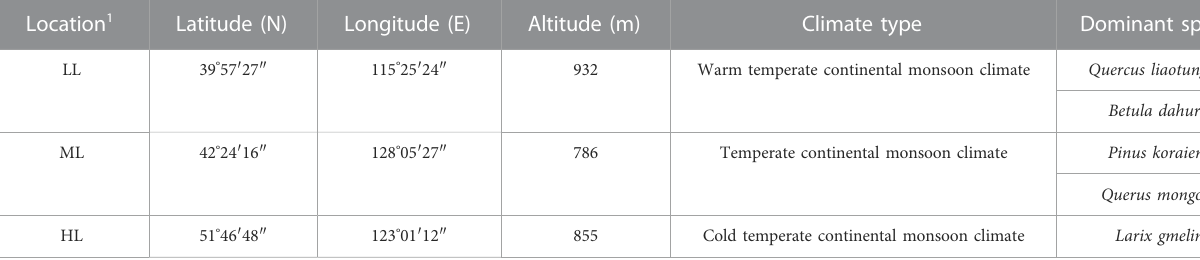
TABLE 1 Basic information of the selected forests in China temperate zones. Location